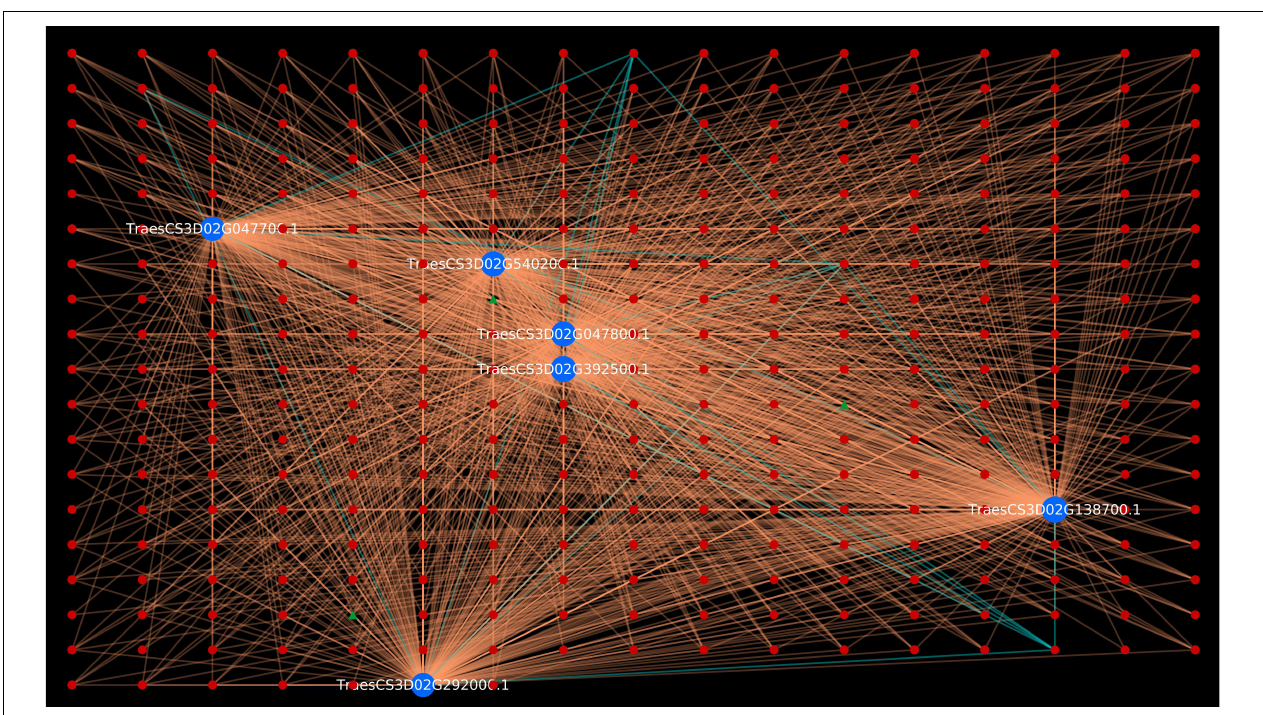
FIGURE 3 | Visualization of six Triticum aestivum proteins belonging to chromosome 3D in GO:0008171 ( O -methyltransferase activity). Blue nodes represent host proteins, red nodes are pathogen proteins, and green nodes are effector proteins. Orange edges depict the interactions from interolog-based approach, while cyan edges belong to domain-based